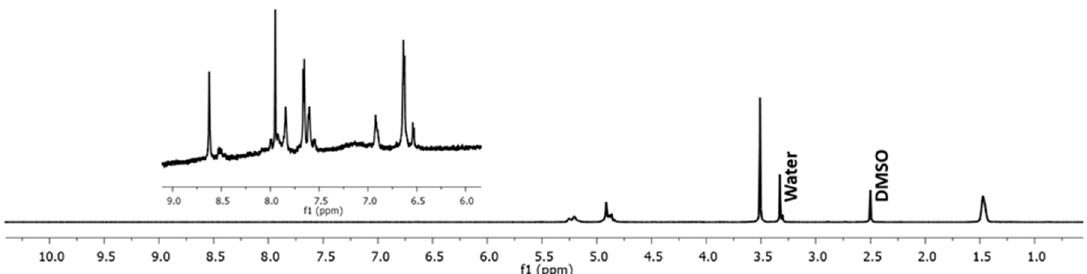
Figure 5. H 1 NMR spectrum of the copolymer SH-PLGA-PEG-FA. The peaks between 9 and 6 ppm correspond to FA protons, while the peaks between 6 and 1 ppm correspond to both PLGA and PEG.